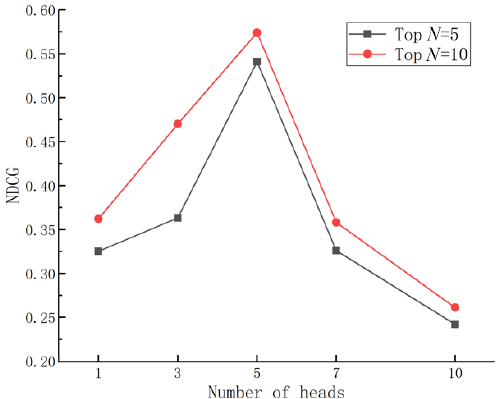
Fig. 5 NDCG with different numbers of heads on the Huajiao